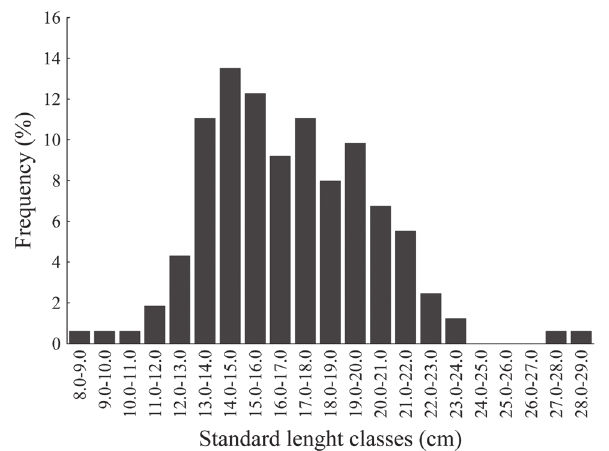
Fig. 3 . Length distribution of Iheringichthys labrosus cap- tured in the Piquiri River from November 2002 to September 2003.